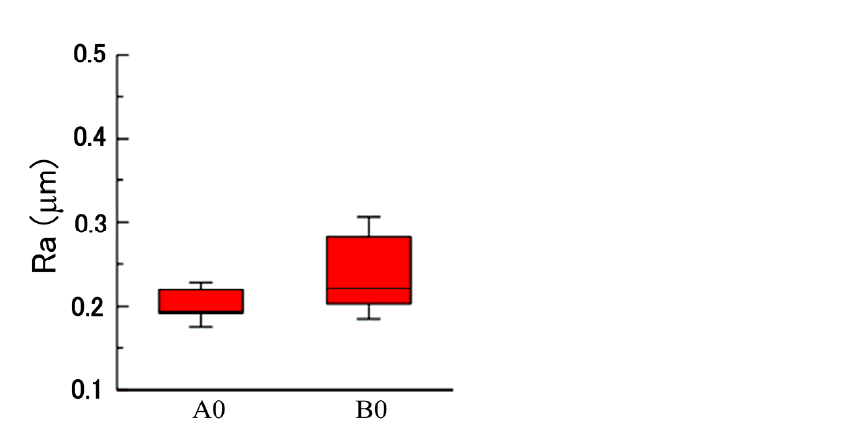
Figure 2. Comparison on roughness before (A0) and after (B0) a plated Cu interlayer on the brass substrate.